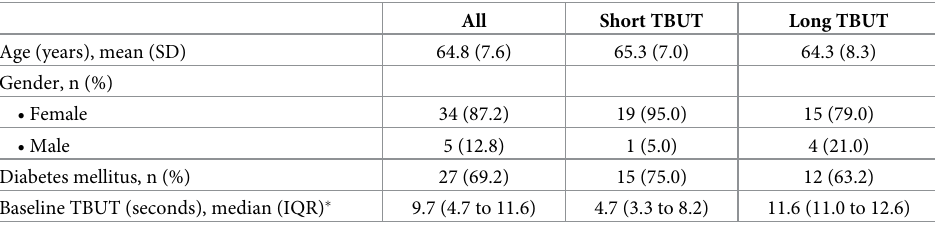
Table 1. Demographic